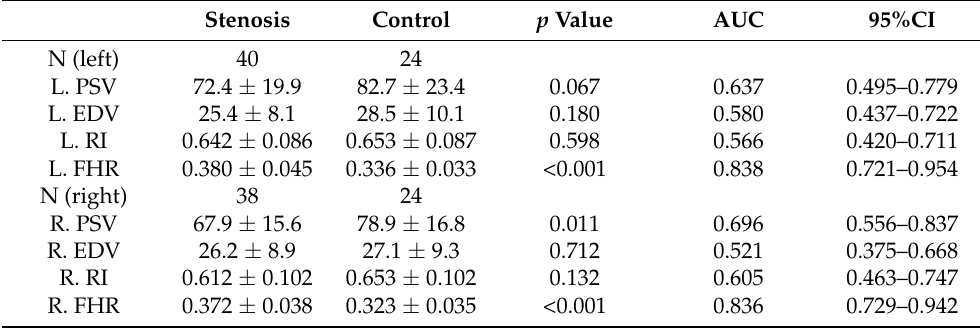
Table 3. Comparison of the hemodynamic indices between the patients with and without intracranial internal carotid artery